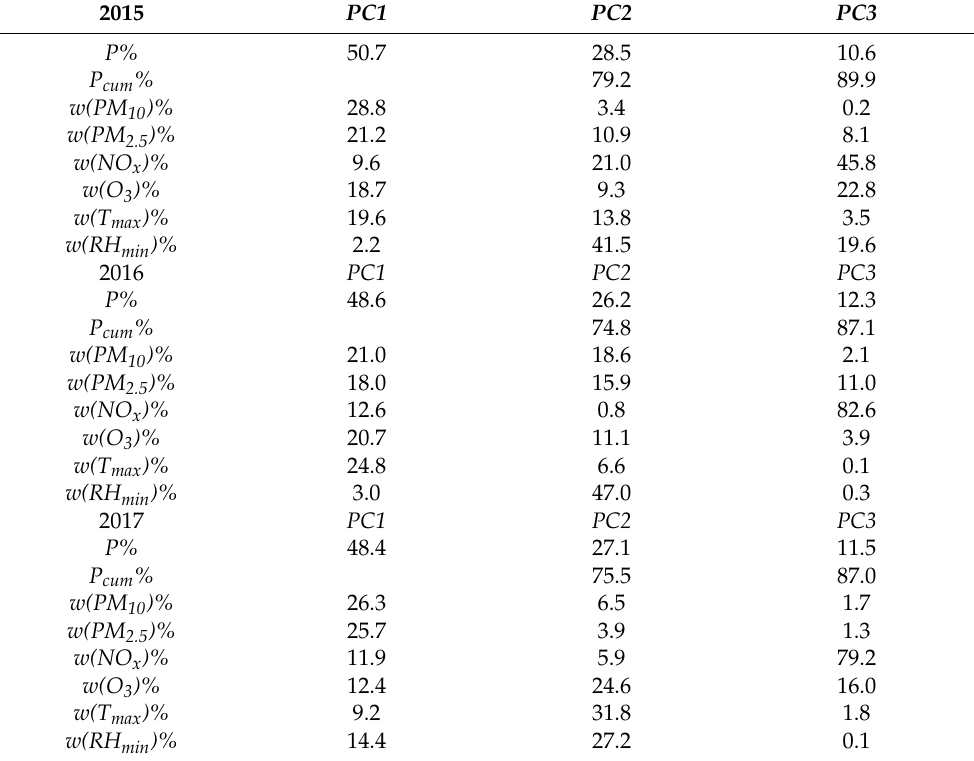
Table 7. PCA results for noHDs detected in SS3 sampling site. In the upper part of the table, the percentage of explained variance ( P% ) and the cumulative percentage ( P cum % ) for the first three Principal Components ( PC ); in the lower part, the percentage weights ( w% ) of the original descriptors in the new